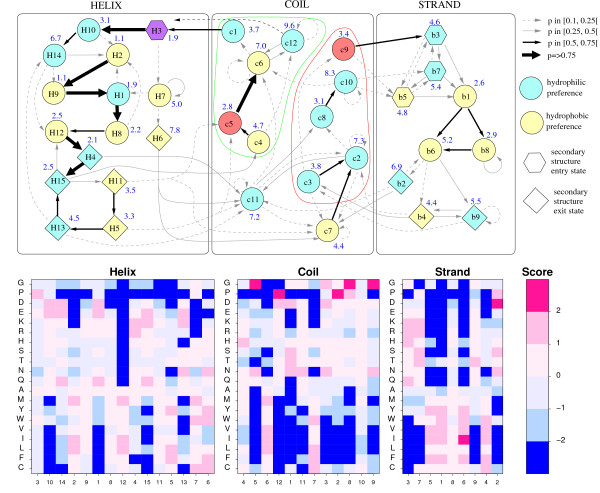
Final 36 hidden states HMM learned using DSSP assignment. Upper part: hidden state graph. Only transitions associated with probabilities greater than 0.1 are shown. The larger the transition probabilities the thicker the arrows. States are colored according to their amino acid preference (hydrophobic versus hydrophilic). Purple state indicates no strong amino acid preference and red states strongly favor glycine. The two groups of coil states (c1, c6, c12, c5, c4) in green and (c3, c2, c8, c10, c9) in red are discussed in the text. For periodic secondary structures, helix and strand, the entry and exit states are indicated by different symbols. Lower part: amino-acid propensities of each hidden state. Propensities are measured by log-odd scores. The propensity score of amino-acid a for state s is given by: S=log2P(a|s)f(a)
 MathType@MTEF@5@5@+=feaafiart1ev1aaatCvAUfKttLearuWrP9MDH5MBPbIqV92AaeXatLxBI9gBaebbnrfifHhDYfgasaacH8akY=wiFfYdH8Gipec8Eeeu0xXdbba9frFj0=OqFfea0dXdd9vqai=hGuQ8kuc9pgc9s8qqaq=dirpe0xb9q8qiLsFr0=vr0=vr0dc8meaabaqaciaacaGaaeqabaqabeGadaaakeaacqWGtbWucqGH9aqpieGacqWFSbaBcqWFVbWBcqWFNbWzdaWgaaWcbaGaeGOmaidabeaakmaalaaabaGaemiuaaLaeiikaGIaemyyaeMaeiiFaWNaem4CamNaeiykaKcabaGaemOzayMaeiikaGIaemyyaeMaeiykaKcaaaaa@3F9E@, with P(a | s) the emission probability of amino-acid a in state s and f(a) the background frequency of a in the dataset. A score equal to 1 means that the amino-acid is twice as frequent in state s as in the whole dataset.